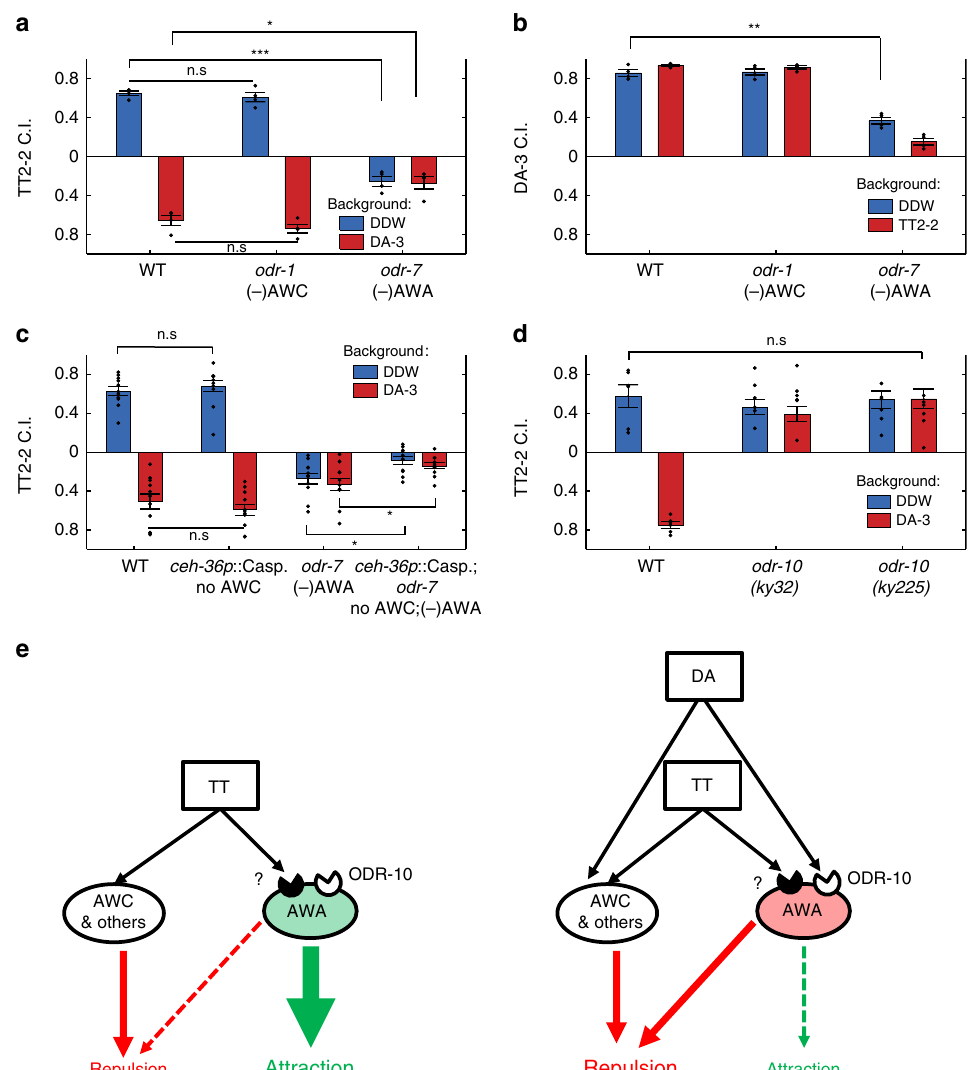
Fig. 6 Sensory modulations, primarily within the AWA neurons, underlie the irrational behavior. a , b Chemotaxis index towards TT (2×10 – 2 , a ) and DA (10 – 3 , b ) in the presence or the absence of a background of DA (10 − 3 , a ), or a background of TT (2×10 − 2 , b ). For all groups, N = 4 experimental repeats (days). c Chemotaxis index towards TT (2×10 − 2 ) in the presence or the absence of a DA background (10 − 3 ). N = 11 experimental repeats for all groups. d Chemotaxis index towards TT (2×10 − 2 ) in the presence or absence of a DA background (10 − 3 ). N = 6 experimental repeats for all groups. Experiments in each of the panels a – d were conducted on the same days, and each experimental day is the average of 2 – 4 plates assayed for each condition and/or strain. Scattered dots are the mean CI of plates in each experimental day. ( − ) in front of a neuron name indicates that the neuron exists but is dis- functional. * p < 0.05, ** p < 0.01, *** p < 0.001 (paired t test). Error bars denote s.e.m. e A proposed model which may explain intransitivity based on our data. Left, when TT is the sole attractant, and in the absence of DA in the background, the prevalent attraction is mediated by AWA, whereas AWC and other neurons mediate negligible repulsion. Right, in the presence of a DA background, DA is sensed by the ODR-10 receptor on the AWA neurons. The action of DA presumably diminishes the AWA-mediated attraction towards TT (at these concentrations) and augments the repulsive response. Dashed arrows indicate the possible modulated effects that AWA neurons (Fig. 1 – 3). In support of this, we found that intransitivity is sig-